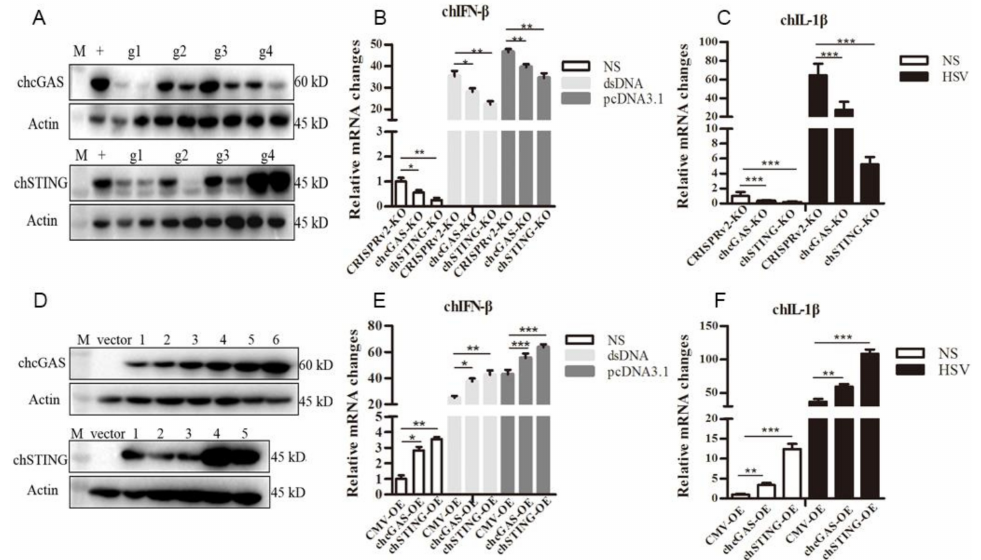
Figure 5. Establishment of chcGAS and chSTING KO and OE stable HD11 cells. ( A ) The e ffi cacies of CRISPR gRNAs to suppress ectopic chcGAS and chSTING expressions. Four lentiviral gRNA plasmids of chcGAS (g1–g4, 0.25, 0.5 µ g each) and chSTING (g1–g4, 0.25, 0.5 µ g each) were co-transfected with chGAS-FLAG (0.5 µ g) and chSTING-FLAG (0.5 µ g), respectively, into 293T cells in 24-well plates. Twenty four hours later, cells were analyzed by Western-blotting with FLAG mAb for chcGAS and chSTING expressions. + denotes plentiCRISPRv2 vector plus chGAS or chSTING; M, protein marker. ( B , C ) The chcGAS KO, chSTING KO and pCRISPRv2 control HD11 cells in 12-well plates were stimulated with dsDNA (0.5 µ g / mL), pcDNA3.1 (0.5 µ g / mL) and Herpes Simplex Virus-1 (HSV-1) (0.01 MOI) for 812 h. The cells were analyzed by RT-qPCR for IFN β and IL-1 β transcriptions. ( D ) The di ff erent plasmids of plentiCMV-chcGAS (clones 1–6) and plentiCMV-chSTING (clones 1–5) were transfected into 293T cells, and, 24 h later cells, were analyzed by Western-blotting with anti-FLAG mAb for chGAS and chSTING expressions. The vector denotes plentiCMV control. ( E,F ) The chcGAS OE, chSTING OE, and pCMV control HD11 cells in 12-well plates were stimulated with dsDNA (0.5 µ g / mL), pcDNA3.1 (0.5 µ g / mL), and HSV-1 (0.01 multiplicity of infection, MOI) for 8-12 h. The cells